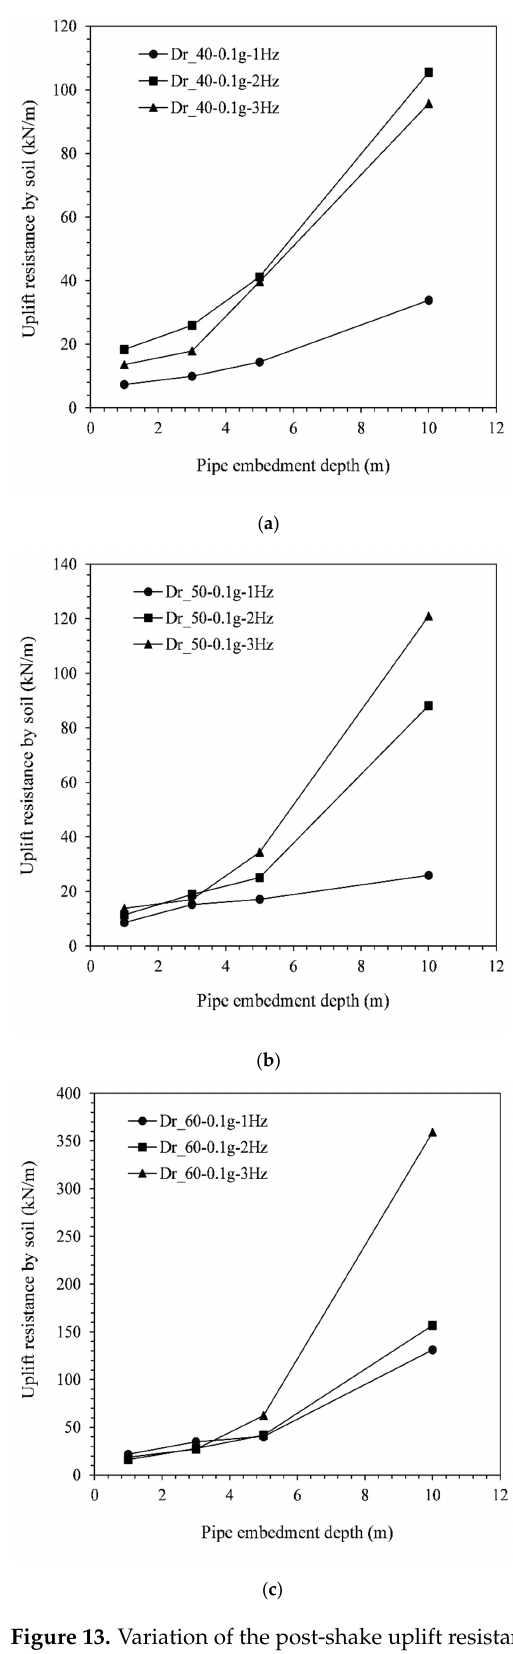
Figure 13. Variation of the post-shake uplift resistance with the pipe embedment depth for different seismic signals and backfill soil densities of ( a ) 40%, ( b ) 50% and ( c ) 60%. The effect of the relative density of the Nevada sand on the post-shake uplift re- sistance of the sand is shown in Figure 14. It can be observed from Figure 14a that the uplift resistance of the soil increases when increasing the relative density of the soil for the 0.1 g and 1 Hz seismic signal. However, for an amplitude of 0.1 g and frequencies of 2 Hz and 3 Hz, the uplift resistance of the soil initially decreased for an increase in the soil relative density of 40% to 50%, while it then increases for a subsequent increase of 50% to 60%. The possible reason of this phenomenon is discussed in the following section. In the post-shake stage, the soil is generally liquefied and has lost the shear strength. Thus, there are two major factors which determines the uplift resistance of the soil. The combined weight of the pipe and the soil above it contribute to the uplift resistance, while an upward buoyant force induced by the liquefied soil works against the uplift resistance. Both the weight of the soil above the pipeline and the buoyant force increases when the soil density is increased. However, the buoyant force also depends on the degree of soil liquefaction. The buoyant force induced by a partially liquefied soil is lower than the buoyant force induced by a completely liquefied soil [33]. From Figure 6 it can be observed that the liquefaction potential at the upper layers increases when the soil density is in- creased. Due to this enhanced liquefaction potential at the upper layer, the buoyant force increased and became predominant when the soil density was increased from 40% to 50%. However, when the soil density was increased from 50% to 60%, the overall liquefaction potential of the soil mass decreased and the weight of the soil above the pipeline became predominant. Thus, the uplift resistance of the soil further increased when the soil relative density was increased from 50% to 60%.